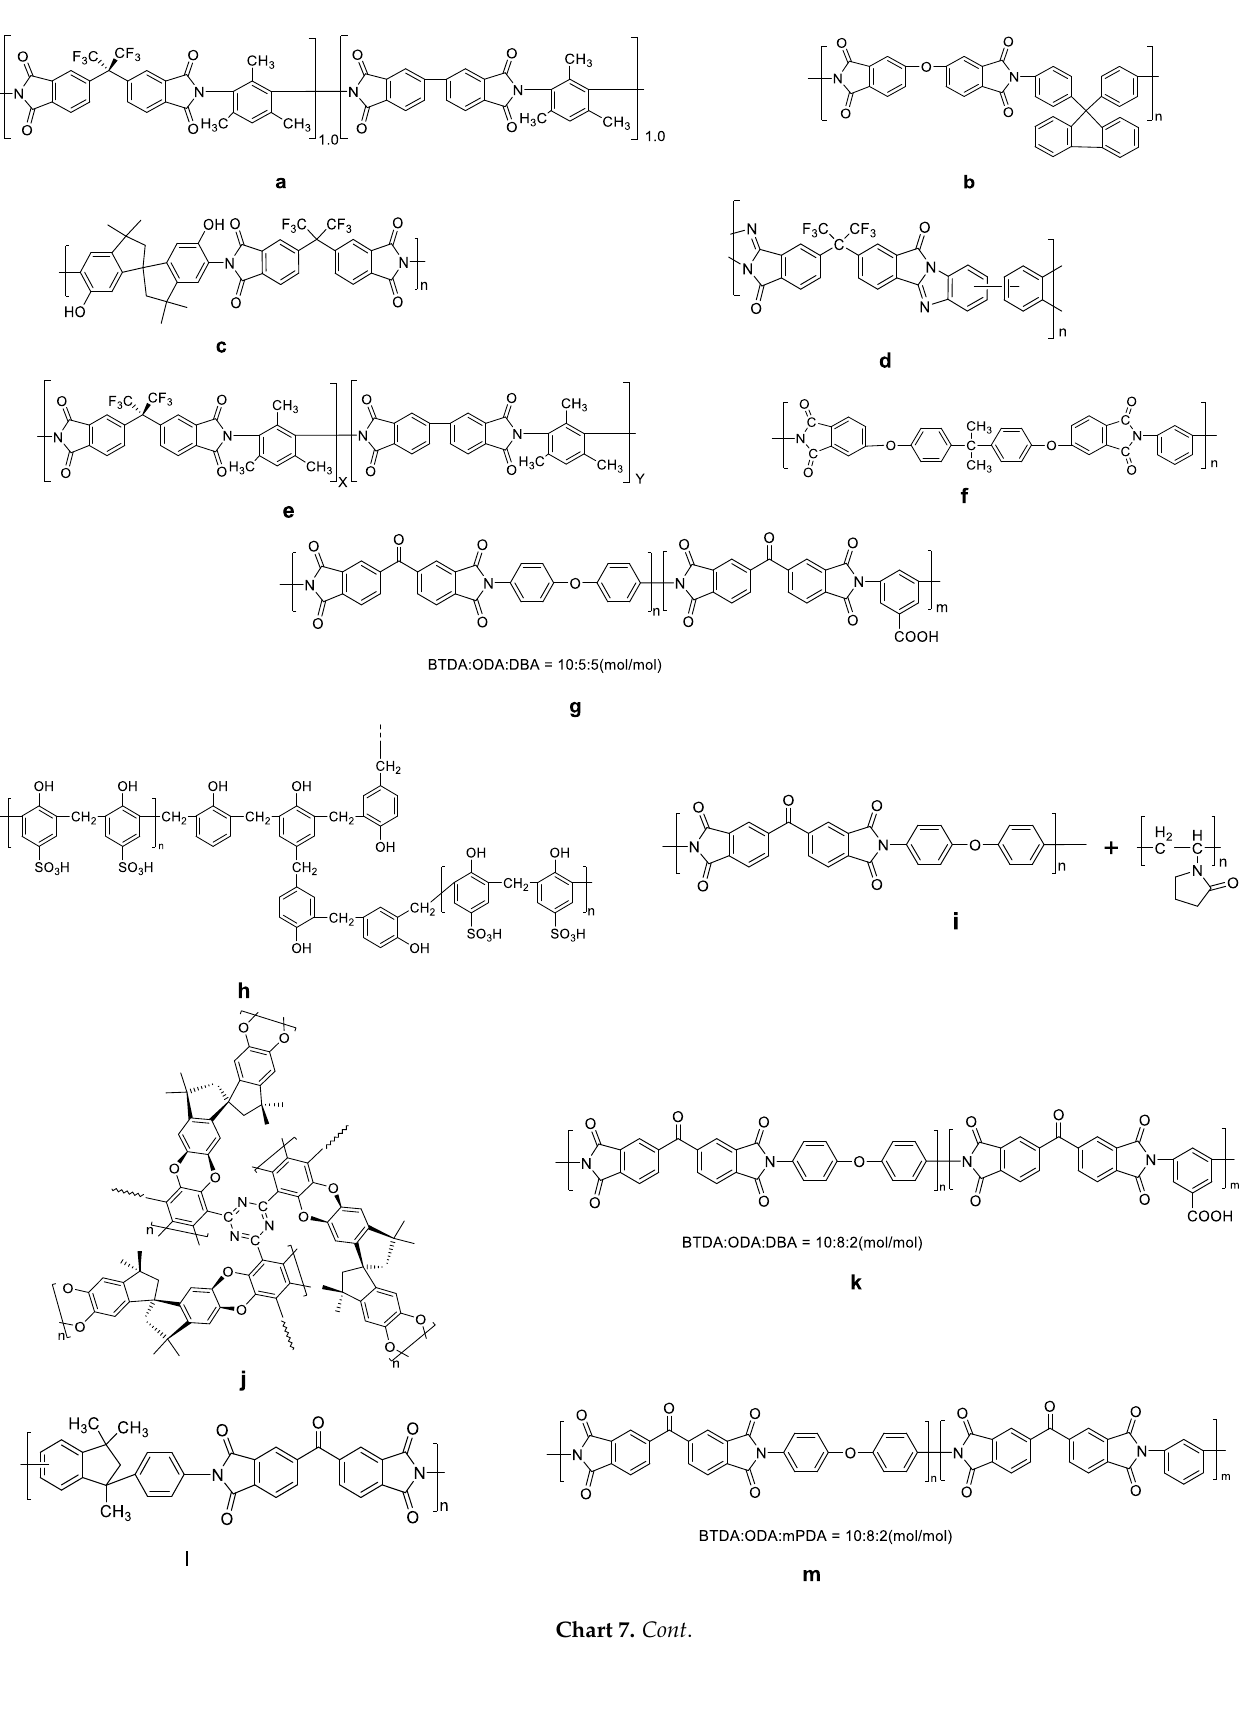
Figure 10. Plots of oxygen permselectivity through carbon molecular sieve membranes (CMSM), showing the highest α at each P O 2 reported in the literature in 2020. For the data and categorization of the precursor polymers of the plots, see Table 8, and for the chemical structures of the precursor polymers of the plots, see Chart 7.